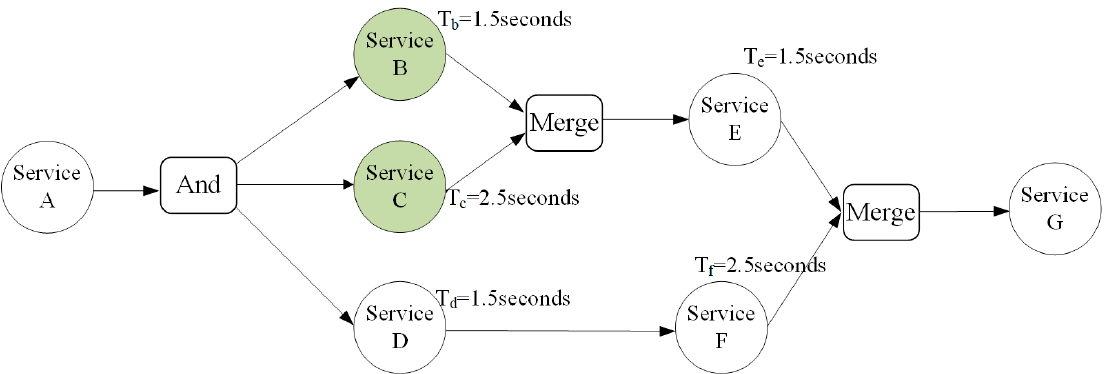
Figure 5. The aggregation of response times in an exemplary service chain (Note: “And” stands for parallel routing, while “Merge” stands for asynchronous join [55]).